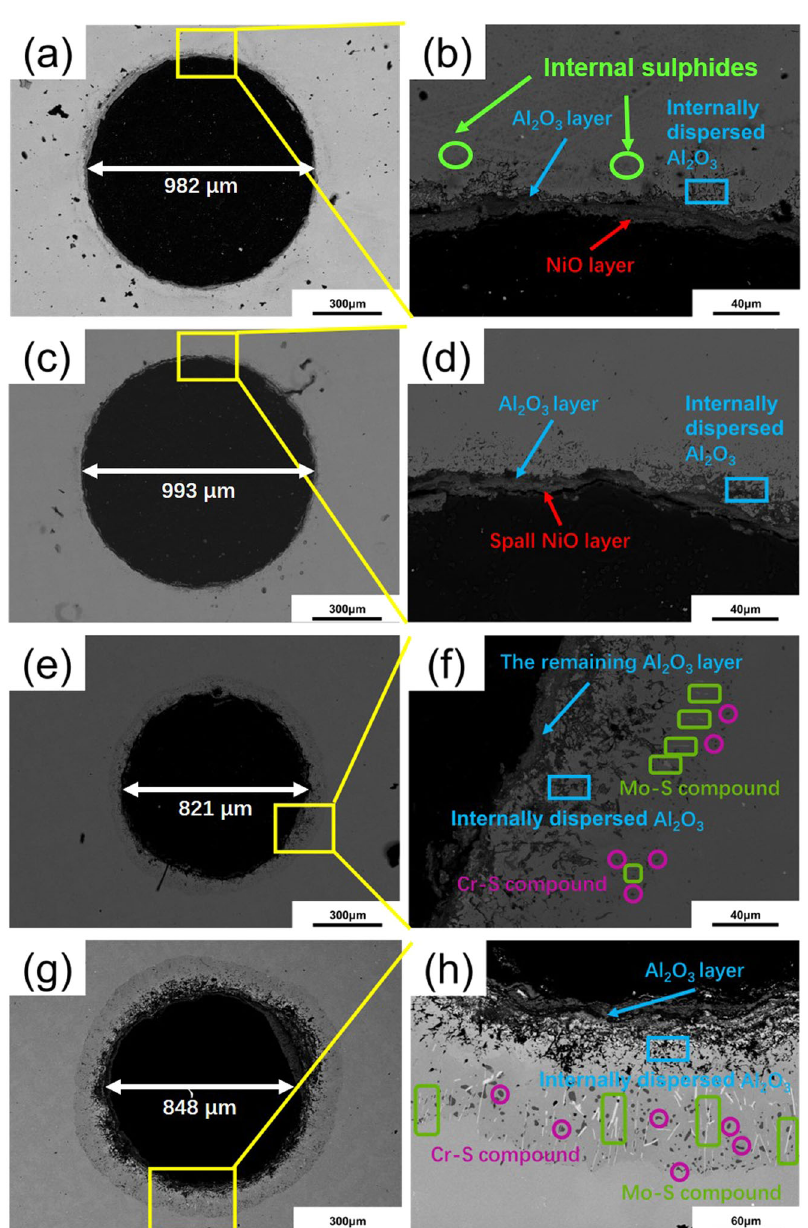
Fig. 7 The cross-section morphologies around the hole after different hot corrosion time at 900 °C. a , b 20 h, c , d 50 h, e , f 100 h, and g , h 200